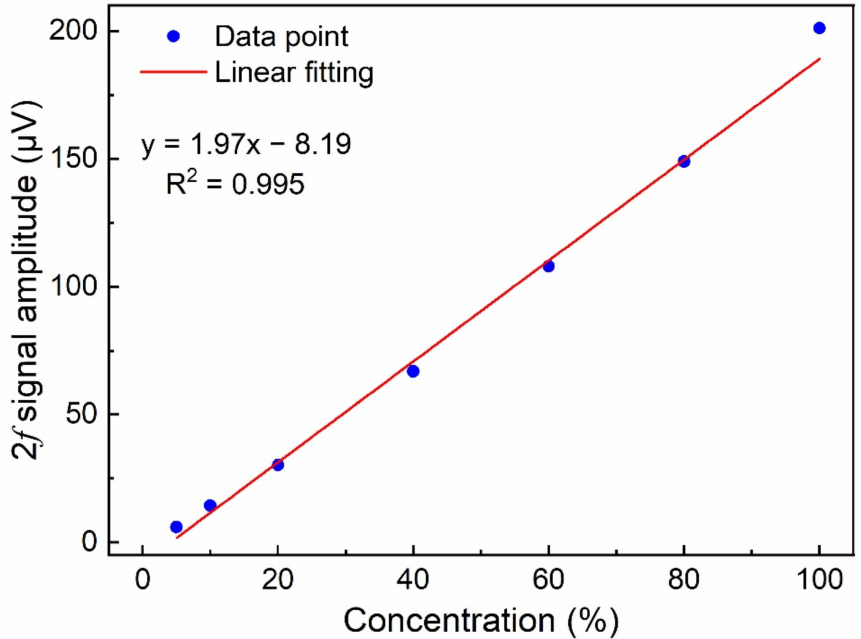
Figure 8. H 2 -TDLAS 2 f signal comparison without and with the DB wavelet denoising when H 2 Figure 6. The linear fitting between the 2 f signal amplitude and H 2 concentration for the H 2 -TDLAS concentration is 100%. sensing